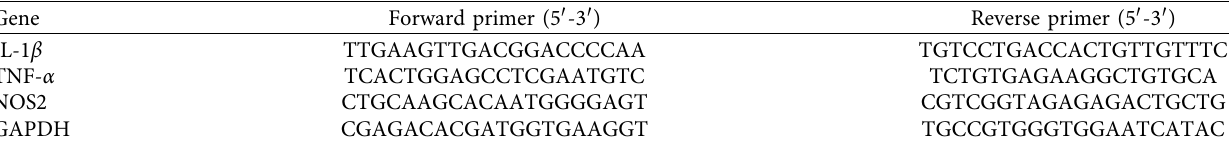
Table 1: Primer sequences.